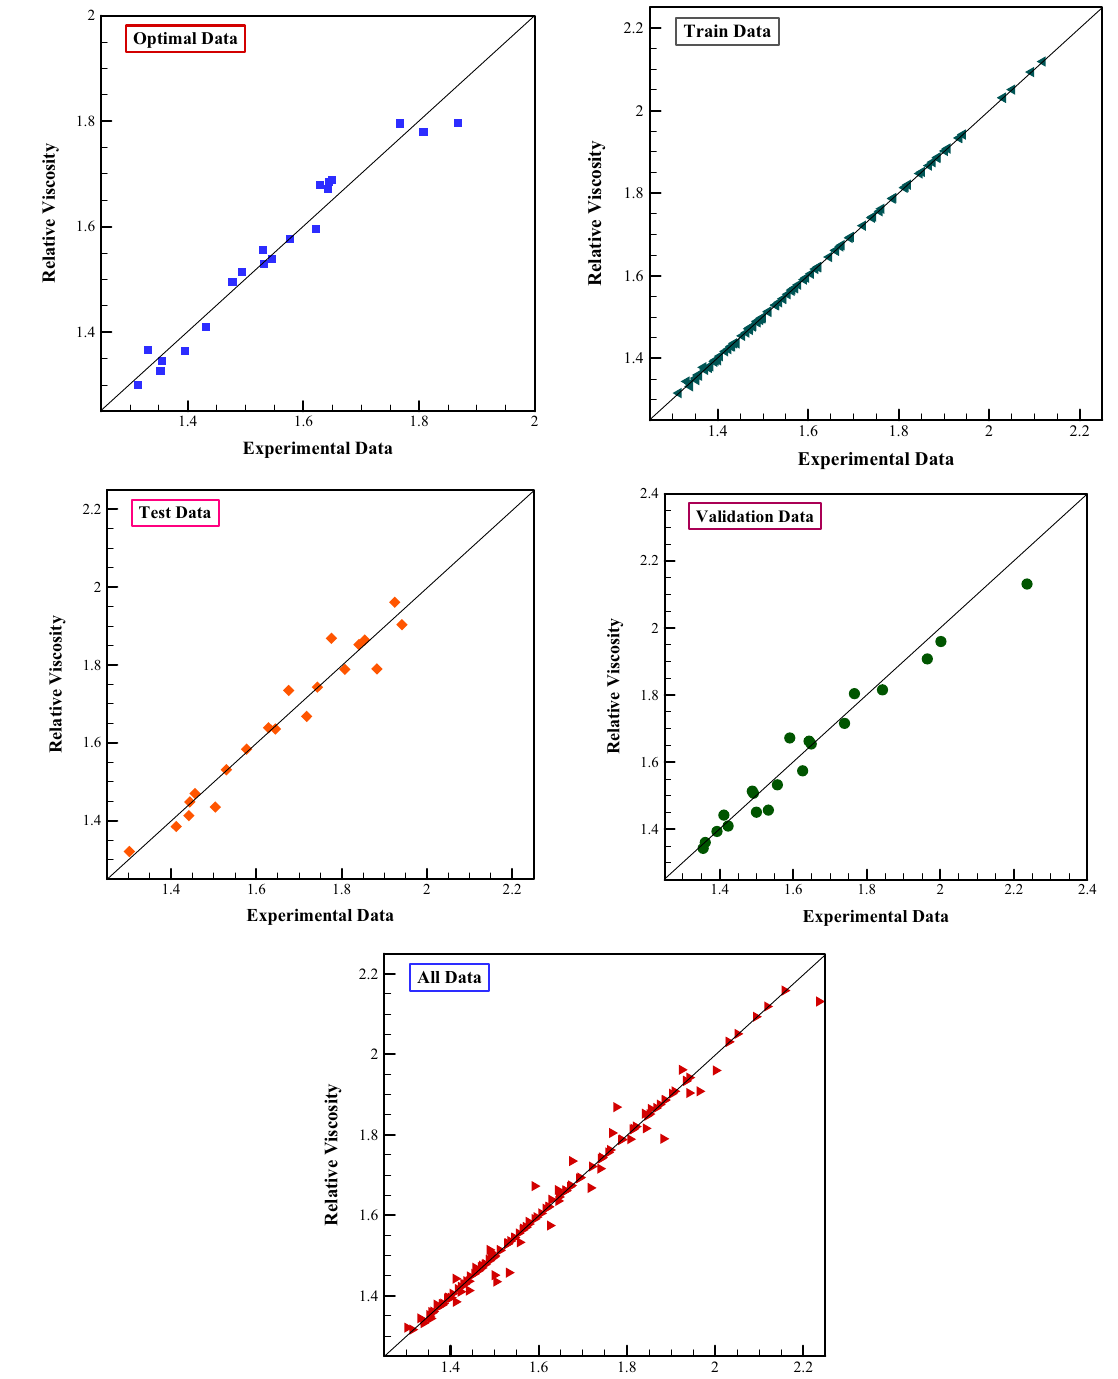
Figure 5. Comparison between predicted data with ANN-based on empirical data for all